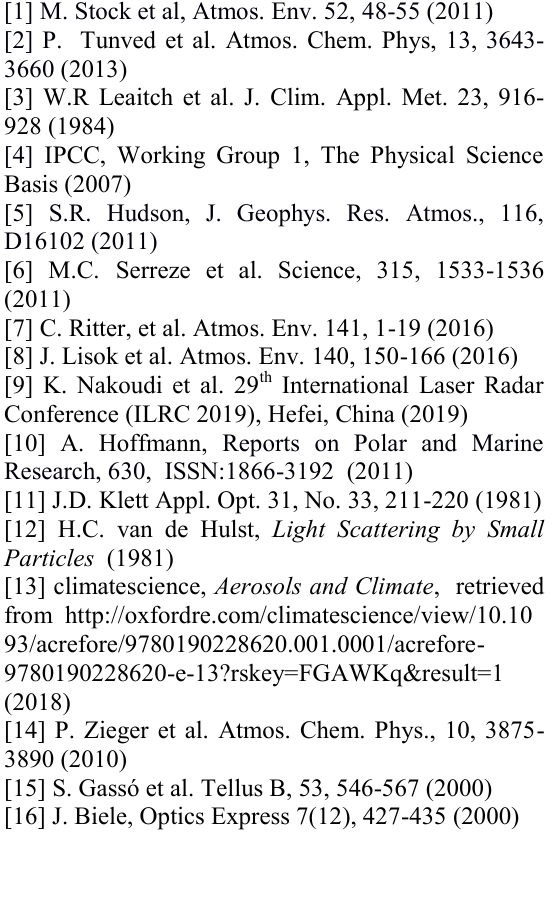
Fig.05: Vertical profile of RH ice . For comparison RH water is shown .